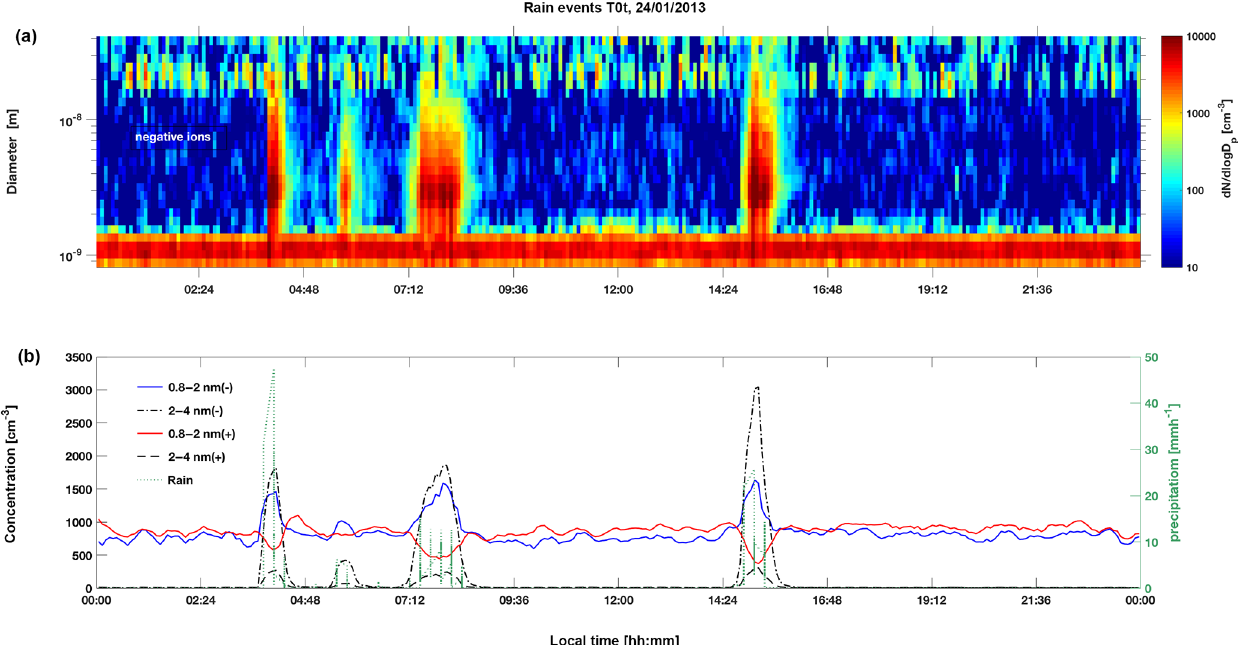
Figure 5. An example measurement for a rain event at the T0t site inside the rainforest is shown. Panel (a) shows the surface figure of the NAIS negative ion channel. Panel (b) shows (i) the concentrations of positive (red line) and (ii) negative (blue line) cluster ions (0.8–2nm) and (iv) positive (dashed black line) and (v) negative (dot-dashed line) intermediate (2–4nm) ions on the left-hand axis. The precipitation rate in mmh − 1 is shown in green on the right-hand